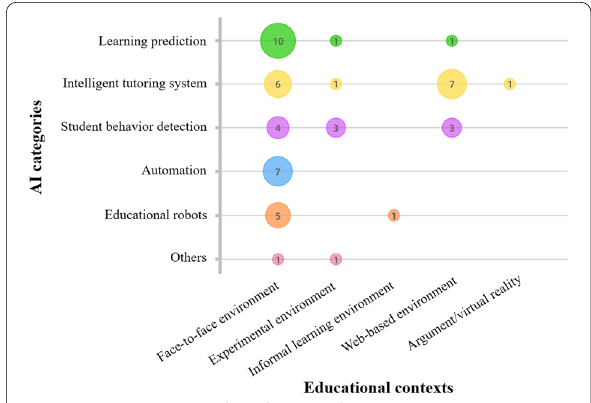
Fig. 10 AI categories under educational contexts ( N